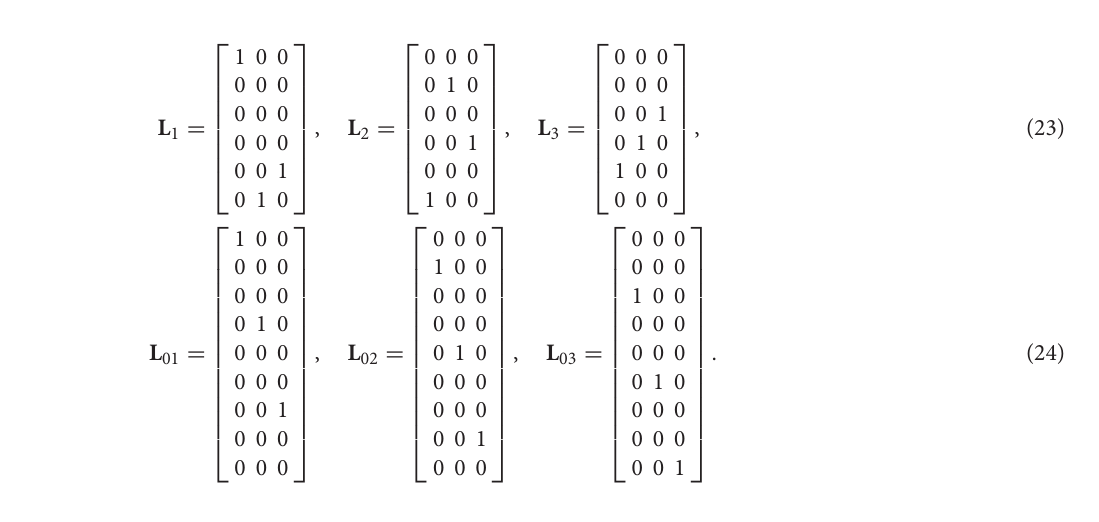
Frontiers in Materials |